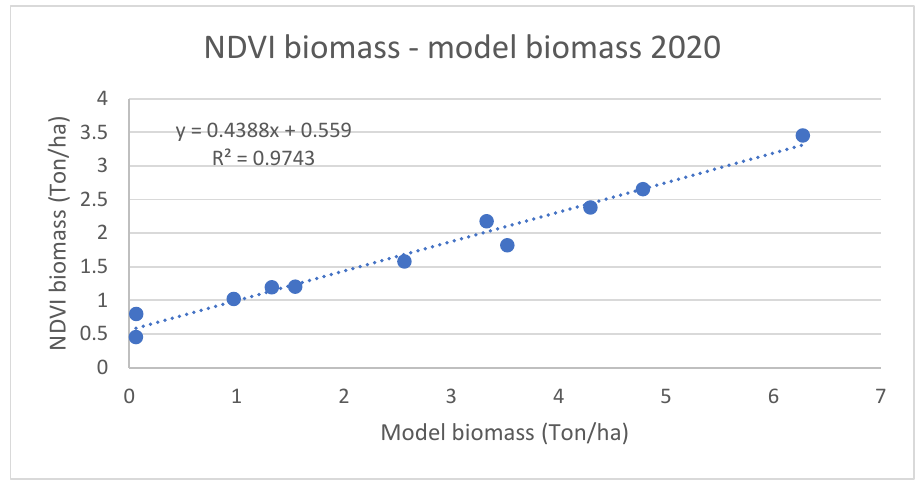
Figure 4. Comparison between NDVI biomass and modeled biomass for winter wheat in 2020.